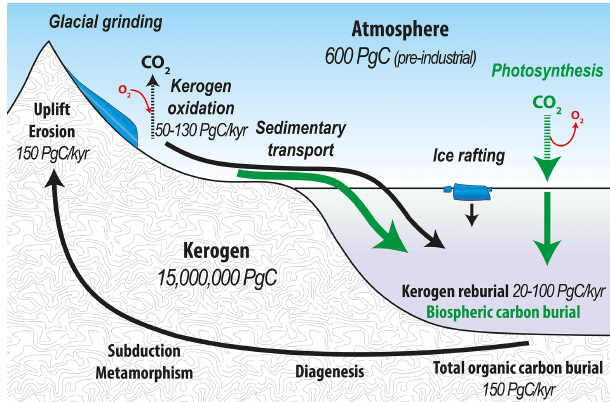
Figure 1. Organic carbon cycle with the flow of kerogen (solid black lines) and the flow of biospheric carbon (solid green lines) showing the fixation of atmospheric CO 2 by both terrestrial and marine primary productivity. The combined flux of reworked kero- gen and biospheric carbon into ocean sediments constitutes the total organic carbon burial into the endogenous kerogen pool (Galy et al., 2015; Hedges and Oades,